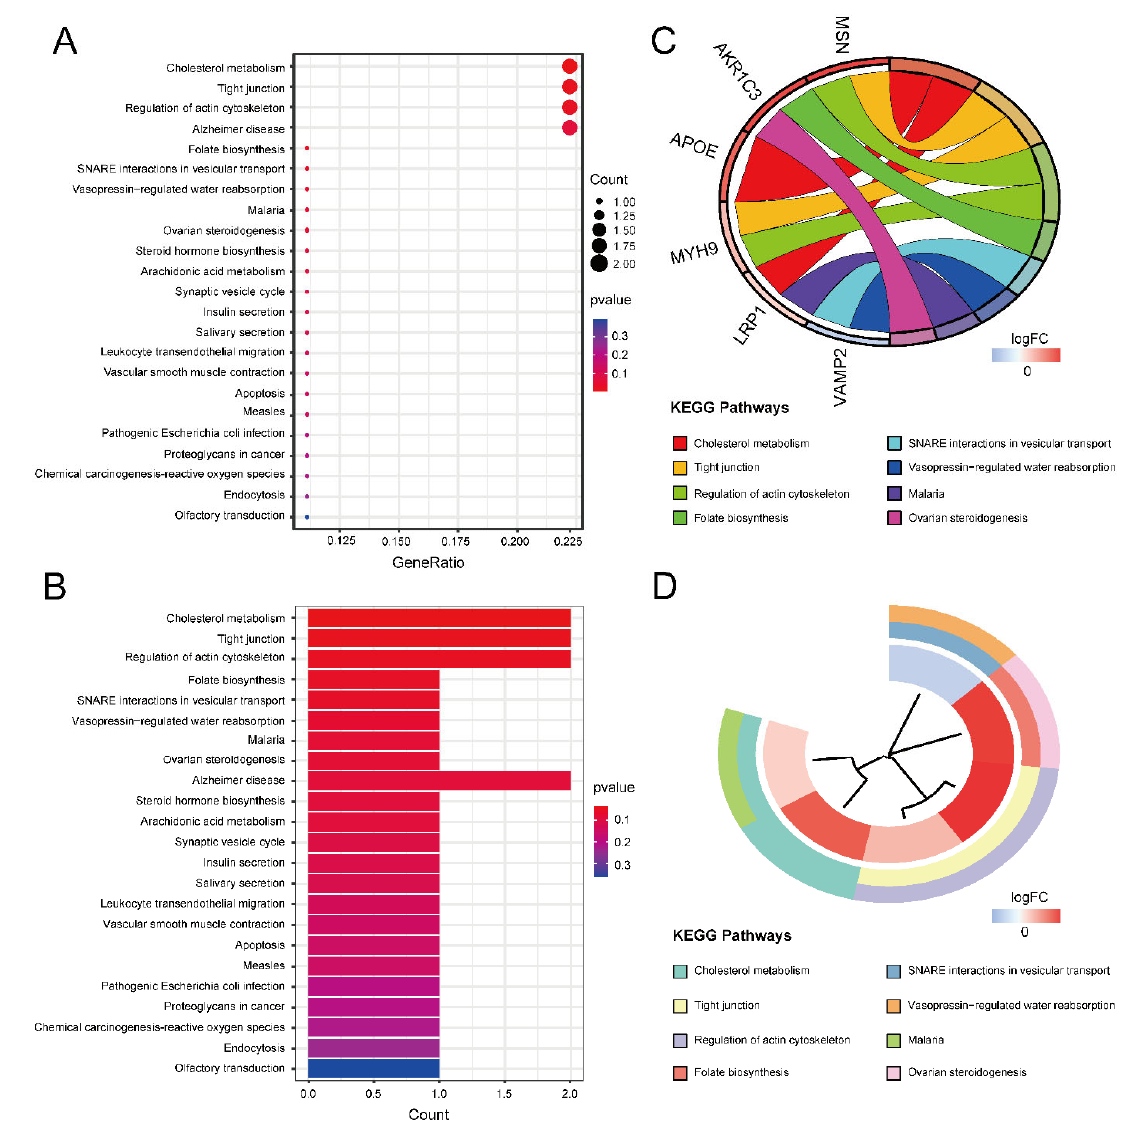
Figure 5. The results of KEGG enrichment analysis. ( A ) KEGG enrichment bubble plot. The x -axis represents the gene ratio, and the y -axis represents the p -value of different pathways. The size of the bubble indicates the number of genes enriched in each KEGG pathway. The redder the color, the smaller the p -value. ( B ) KEGG enrichment bar graph. The redder color indicates a smaller p -value. ( C ) KEGG enrichment chord plot. Genes are shown on the left, where red gene bands indicate up-regulated expression, and blue gene bands indicate down-regulated expression. The different colored bands on the right represent different pathways. Lines connect genes and their corresponding pathways. ( D ) KEGG enrichment phylogenetic plot. The bands with different colors in the innermost circle represent different genes, and the bands with different colors in the outer circle represent the enriched pathways of the corresponding genes.